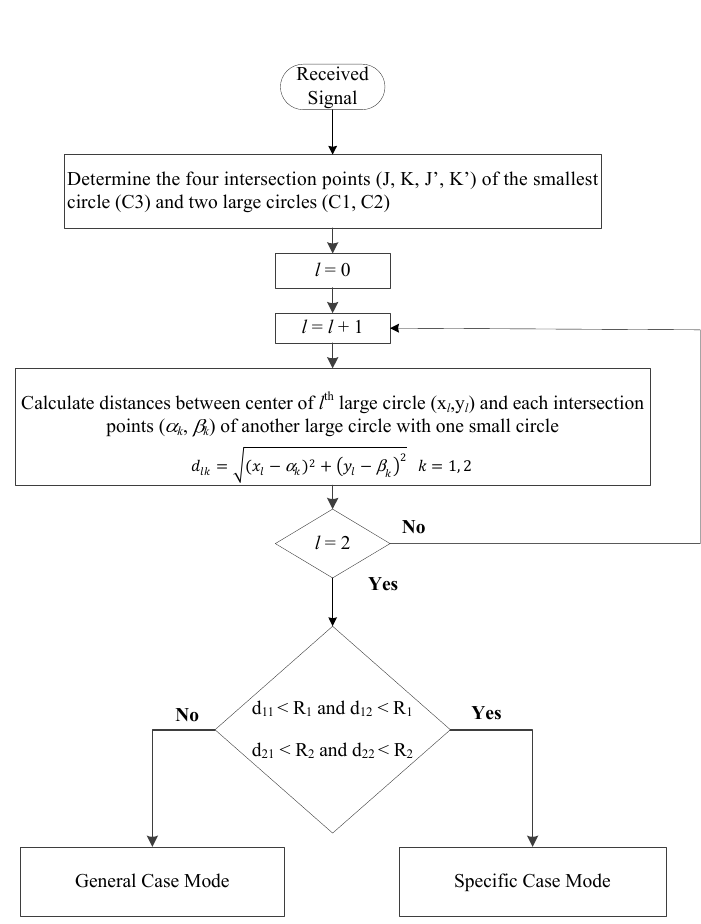
Figure 7. Flow chart of the mode selection algorithm.